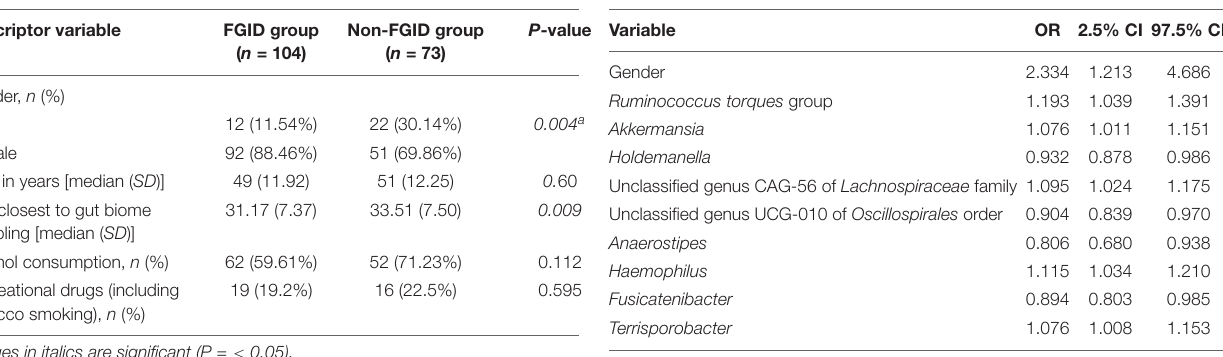
TABLE 1 | Distribution and demographics of FGID and non-FGID groups in the study.